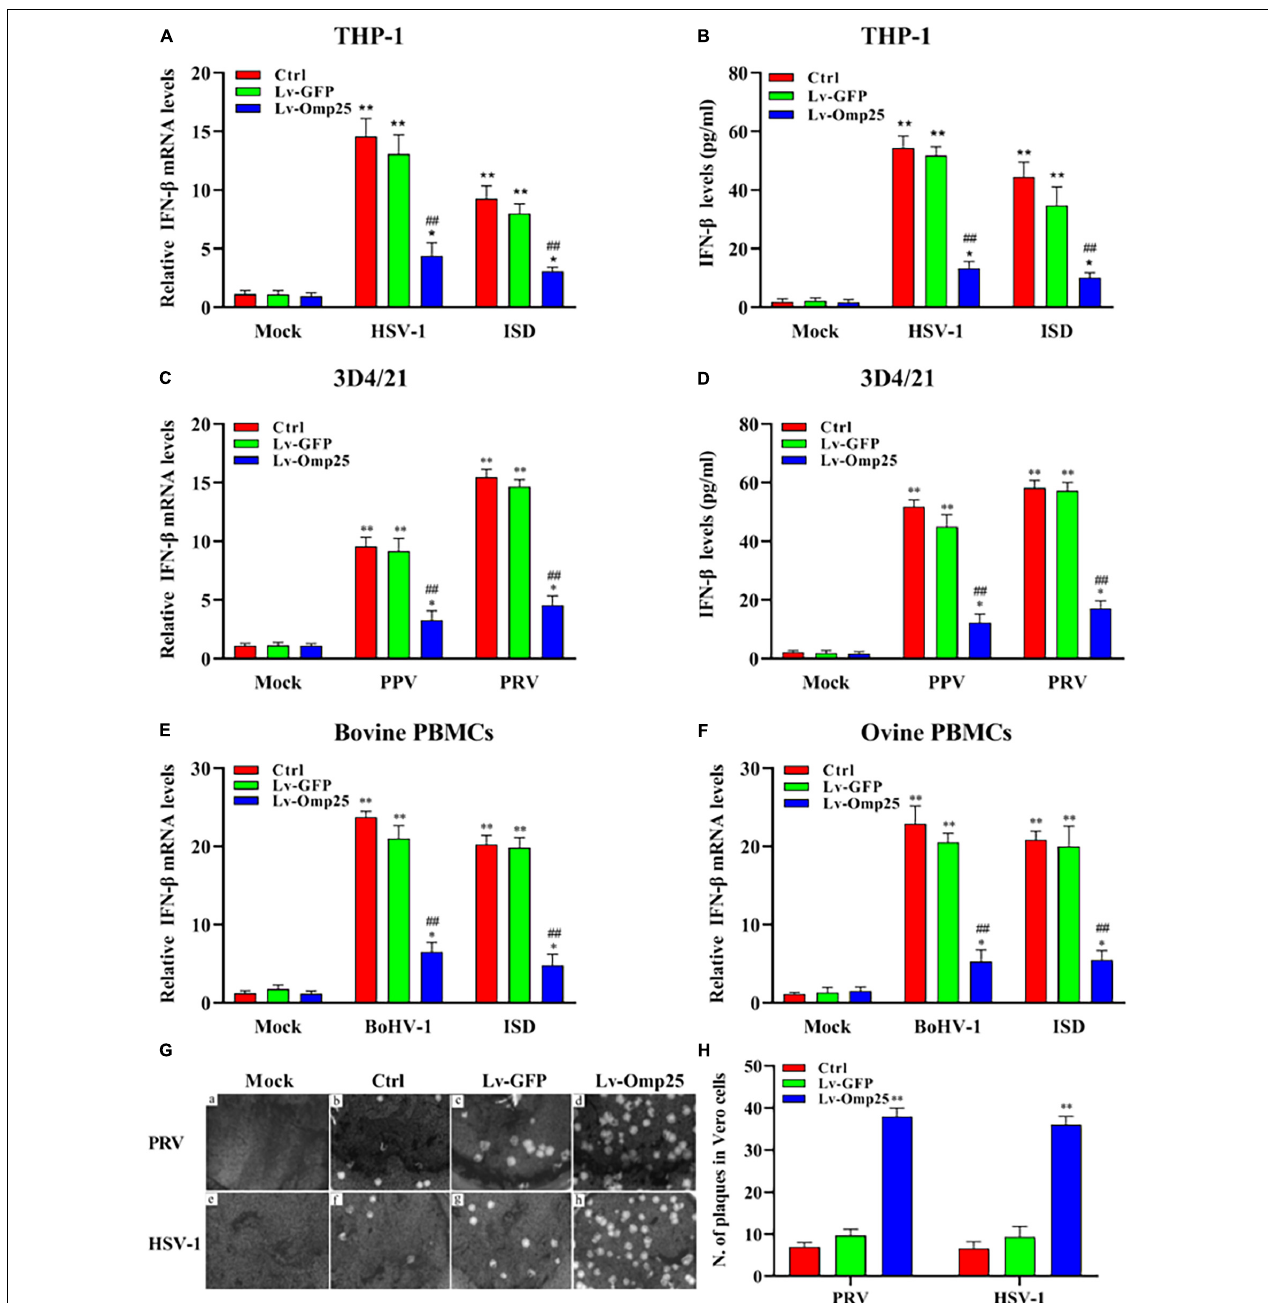
FIGURE 2 | Omp25 inhibits DNA virus and ISD-induced IFN- β expression in various mammalian monocyte/macrophages. (A) Omp25 inhibits IFN- β expression in THP-1 cells. THP-1 cells were infected with 100 multiplicity of infection (MOI) of Lv-Omp25 or Lv-GFP for 48 h and then infected with HSV-1 (10 MOI) or transfected with ISD (2 µ g/ml) for another 6 h. Cells were harvested and subjected to qRT-PCR analysis. (B) Omp25 inhibits IFN- β production in THP-1 cells. THP-1 cells were infected with 100 MOI of Lv-Omp25 or Lv-GFP for 48 h and then infected with HSV-1 (10 MOI) or transfected with ISD (2 µ g/ml) for another 24 h. Cells were harvested and subjected to ELISA analysis. (C,D) Omp25 inhibits PPV- or PRV-induced IFN- β transcription and expression in 3D4/21 cells. Cells were infected and treated as discussed earlier and then infected with PPV (1 MOI) or PRV (1 MOI) for another 6 or 24 h. Cells were harvested and subjected to qRT-PCR analysis or ELISA analysis. (E,F) Omp25 inhibits BoHV-1-induced IFN- β transcription in bovine and ovine PBMCs. Cells were infected and treated as in discussed earlier and then infected with BoHV-1 (1 MOI) or stimulated with ISD (2 µ g/ml) for another 6 h. Cells were harvested and subjected to qRT-PCR analysis. (G,H) Omp25 inhibits PRV and HSV-1 replication. Vero cells were infected with 100 MOI of Lv-Omp25 or Lv-GFP for 48 h and then infected with HSV-1 (10 MOI) or PRV (1 MOI) for 1 h and overlayed with methylcellulose for 3 days, and then, cells were stained with 5% crystal violet hydrate solution for 30 min (G) . Number of plaque by taking average number of viruses in per well (H) . Results are means ± SEMs of three independent experiments. * P < 0.05, ** P < 0.01 versus mock group, # P < 0.05, ## P < 0.01 versus control or Lv-GFP-infected cells in same secondary infection or stimulation groups.